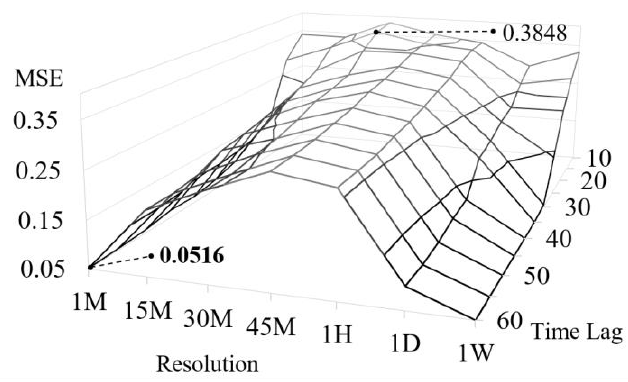
Figure 7. Comparison of MSEs by the time lag parameter ω .